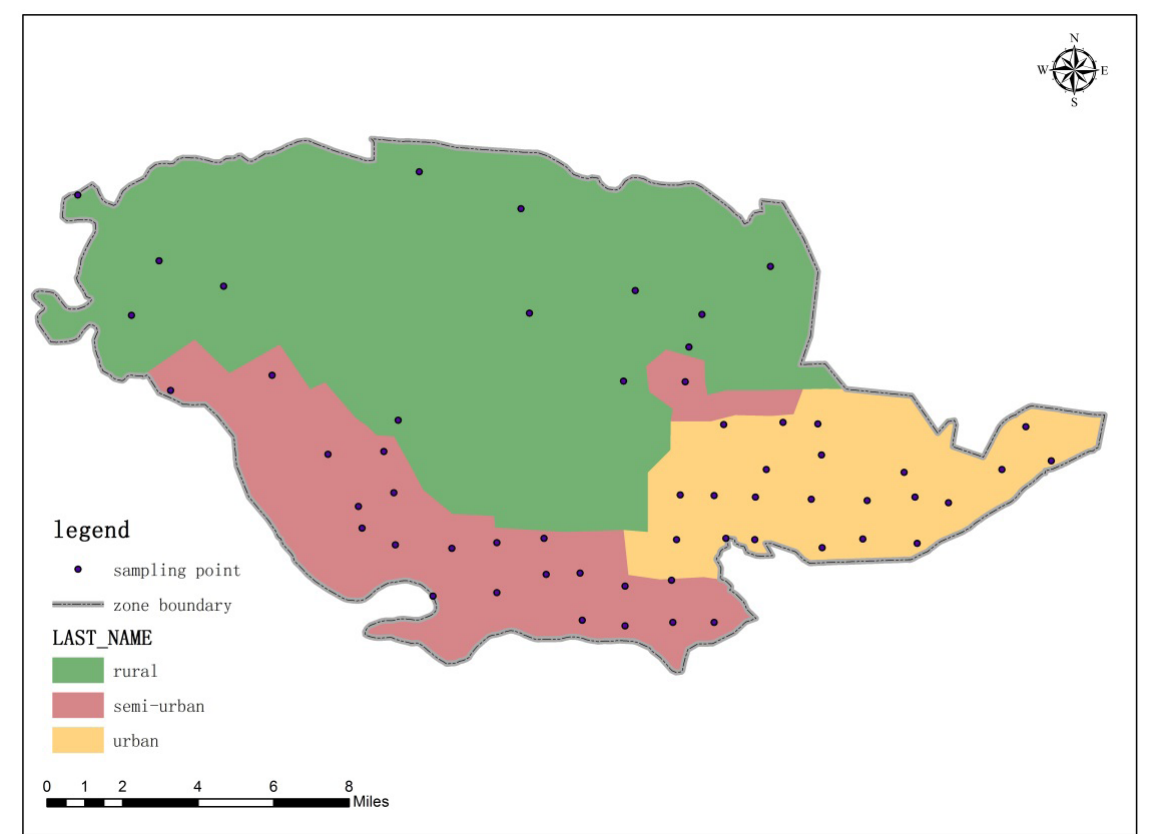
Figure 2: Areas of different urbanization